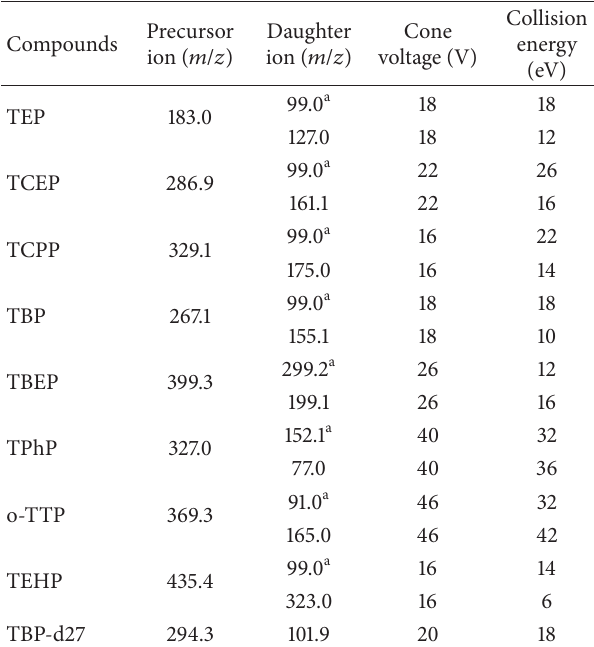
Table 1: MS parameters of OPE compounds and TBP-d27 internal standard.